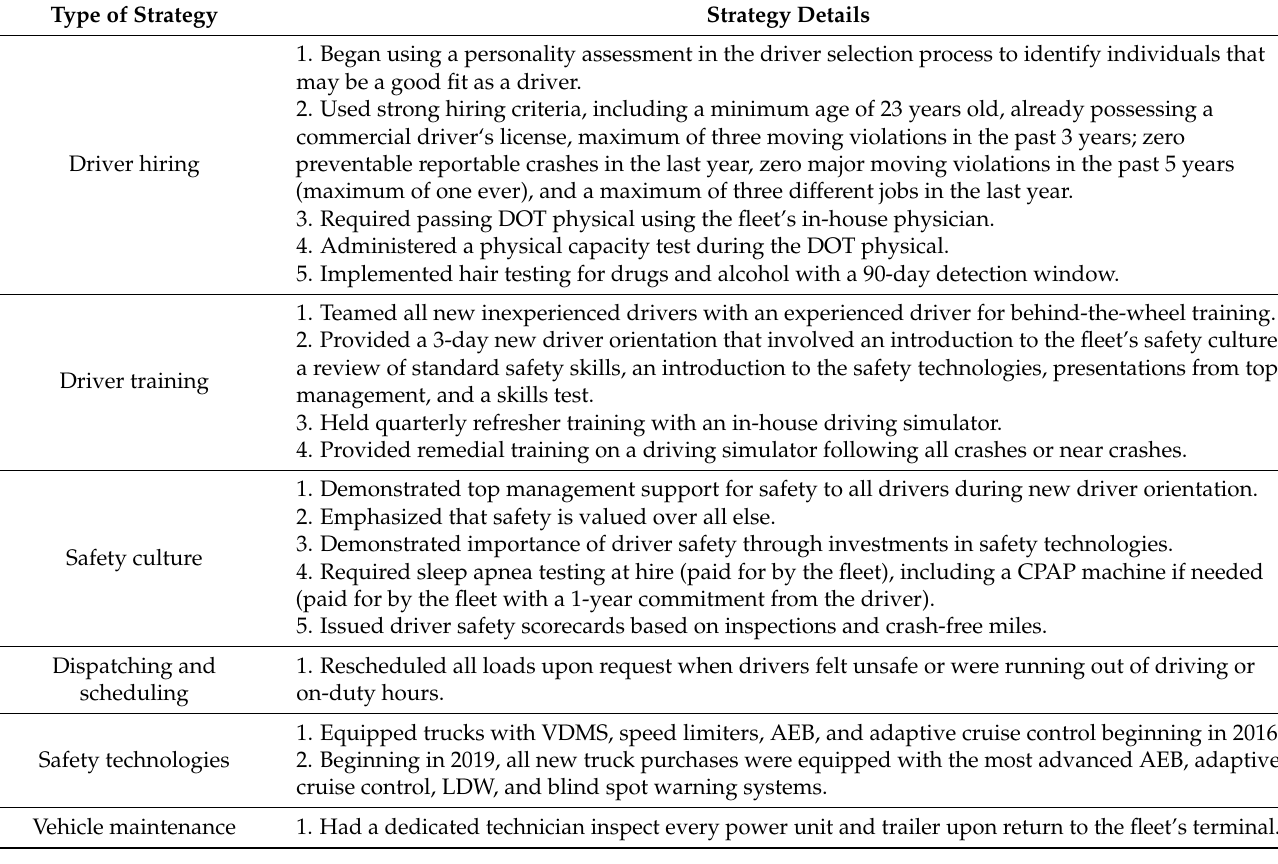
Table 7. Fleet E’s safety improvement strategies.